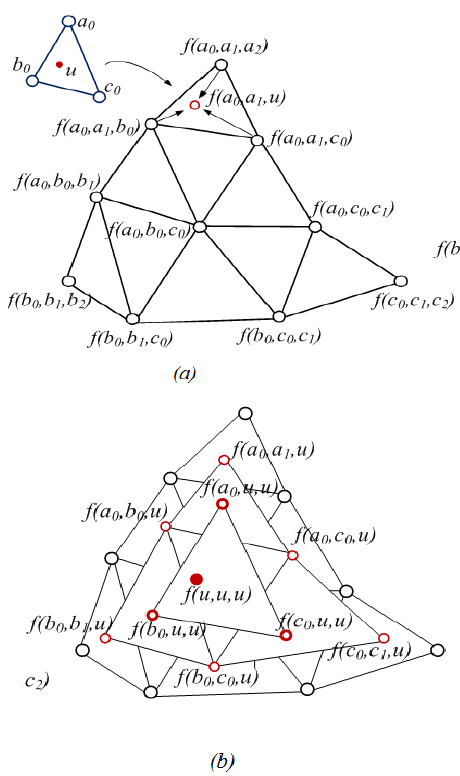
Figure 3. A cubic B-patch: (a) blending three control points and (b) evaluating B-patch.